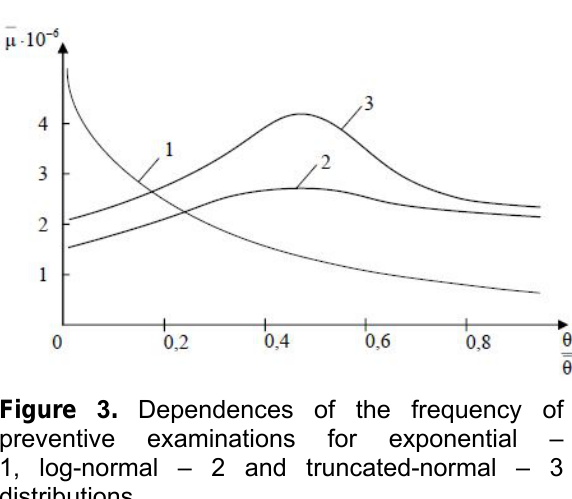
Figure 3 . Dependences of the frequency of preventive examinations for exponential – 1, log-normal – 2 and truncated-normal – 3